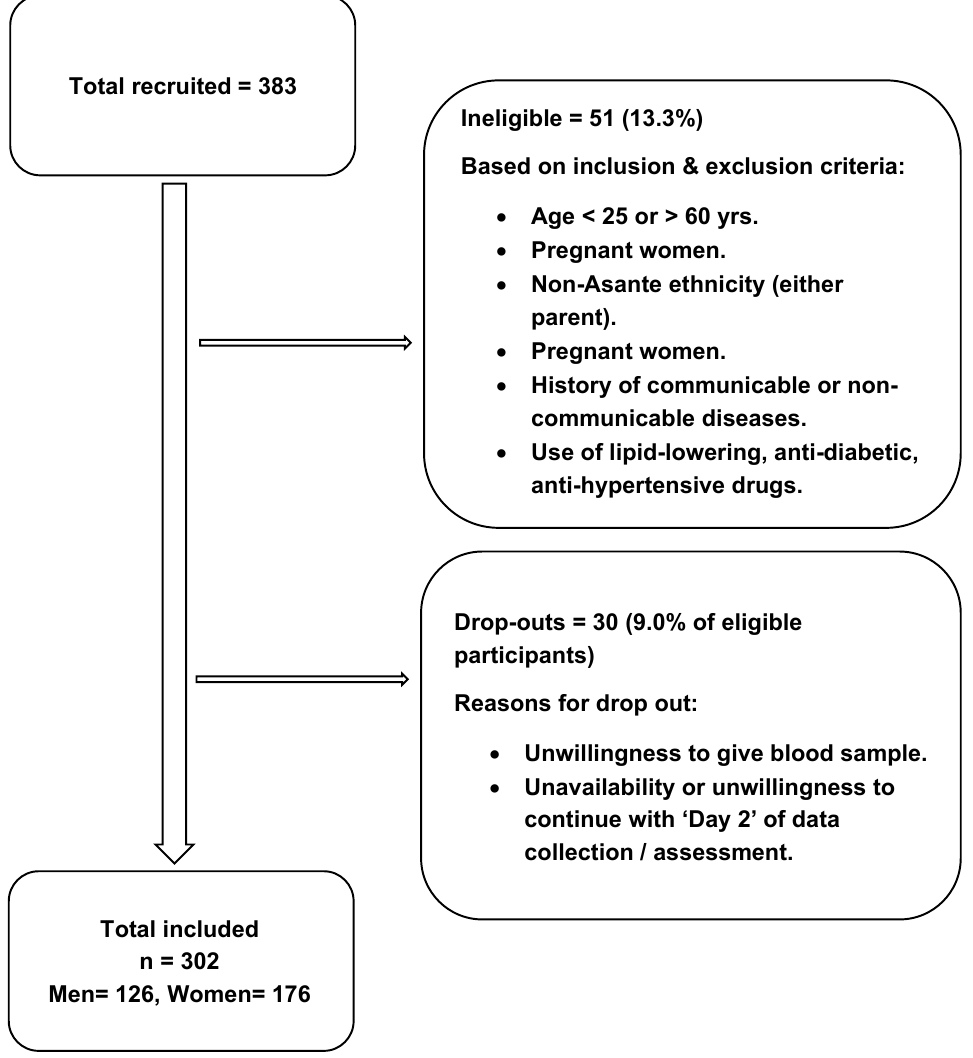
Figure 1. Flow chart showing the recruitment of the study participants.